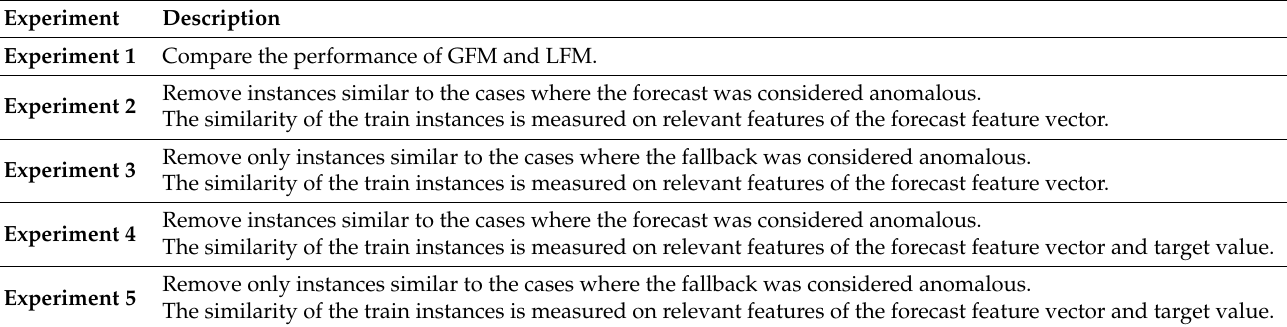
Table 3. Description of the experiments that we performed.